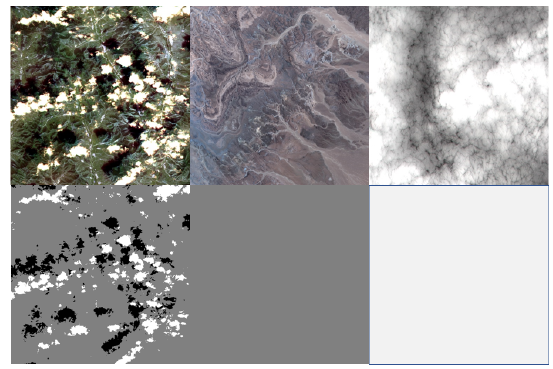
Figure 1. Examples of remote sensing scenes and their pixel-wise labels with three classes (white for cloud, black for shadow and gray for clear). For part of scenes having no cloud or clear pixels, we explore to capture global context of such